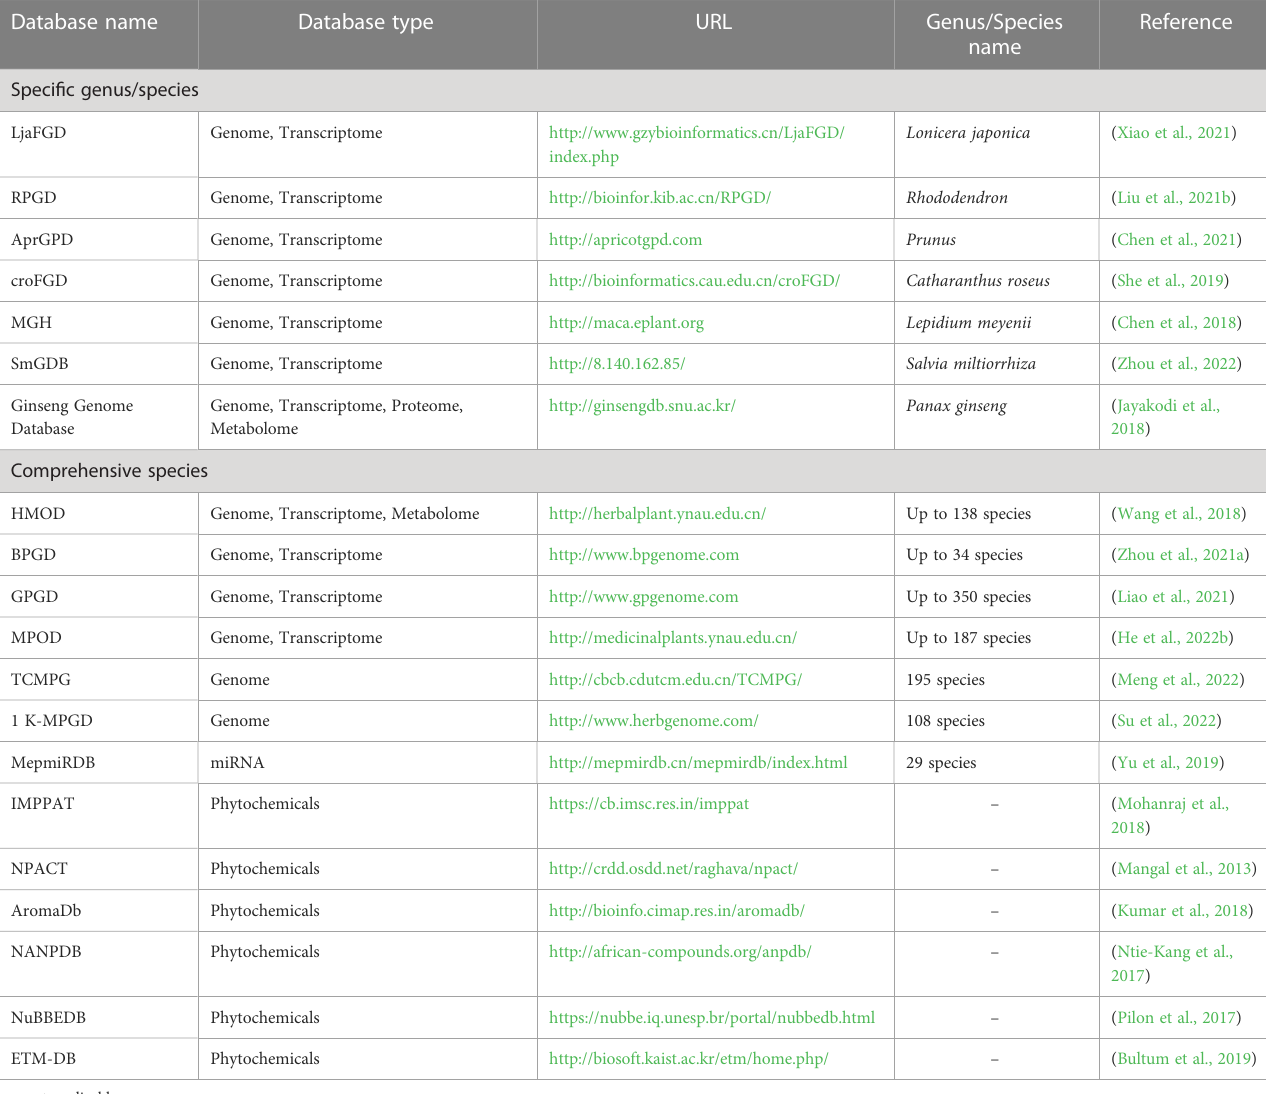
TABLE 1 Databases on medicinal plant -omics and